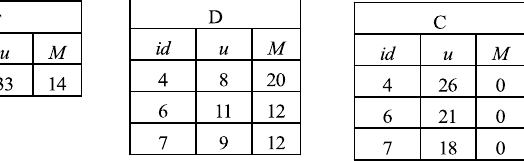
Fig. 4 UL structures of item